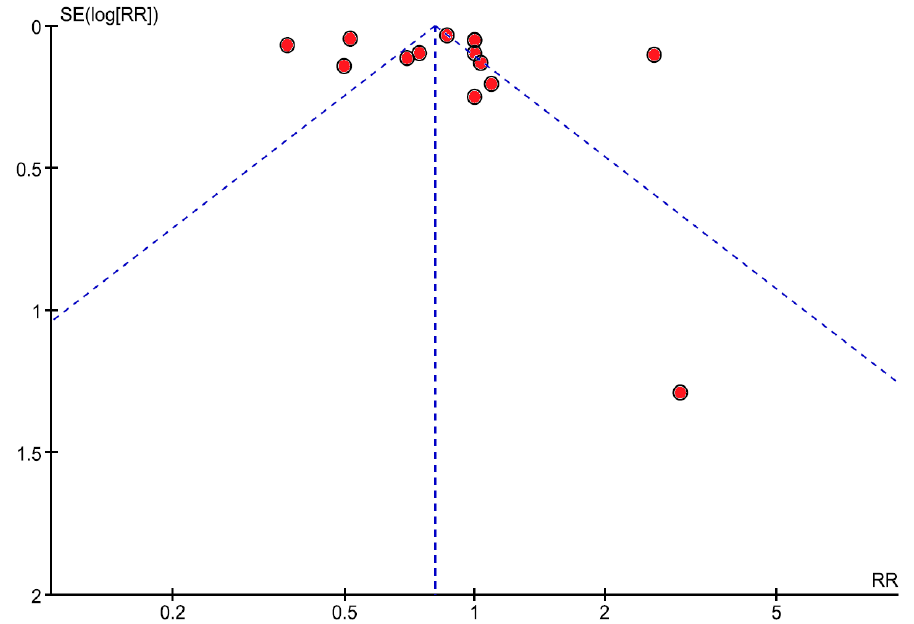
Figure 3. Funnel plot shows the heterogeneity between the studies included in the meta-analysis. Heterogeneity: Chi2 = 452.57, df = 17 ( p = 0.00001), I2 = 96%.